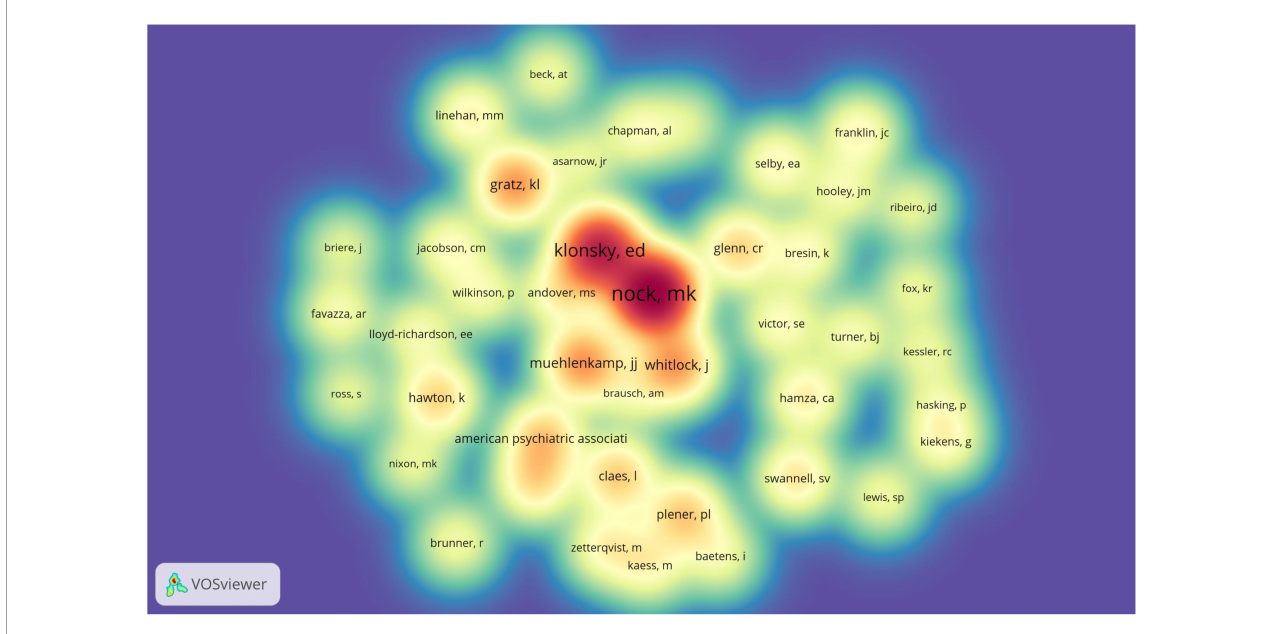
FIGURE9 The density map of co-citation authors generated by VOSviewer. The deeper of color, the more representative authors is.